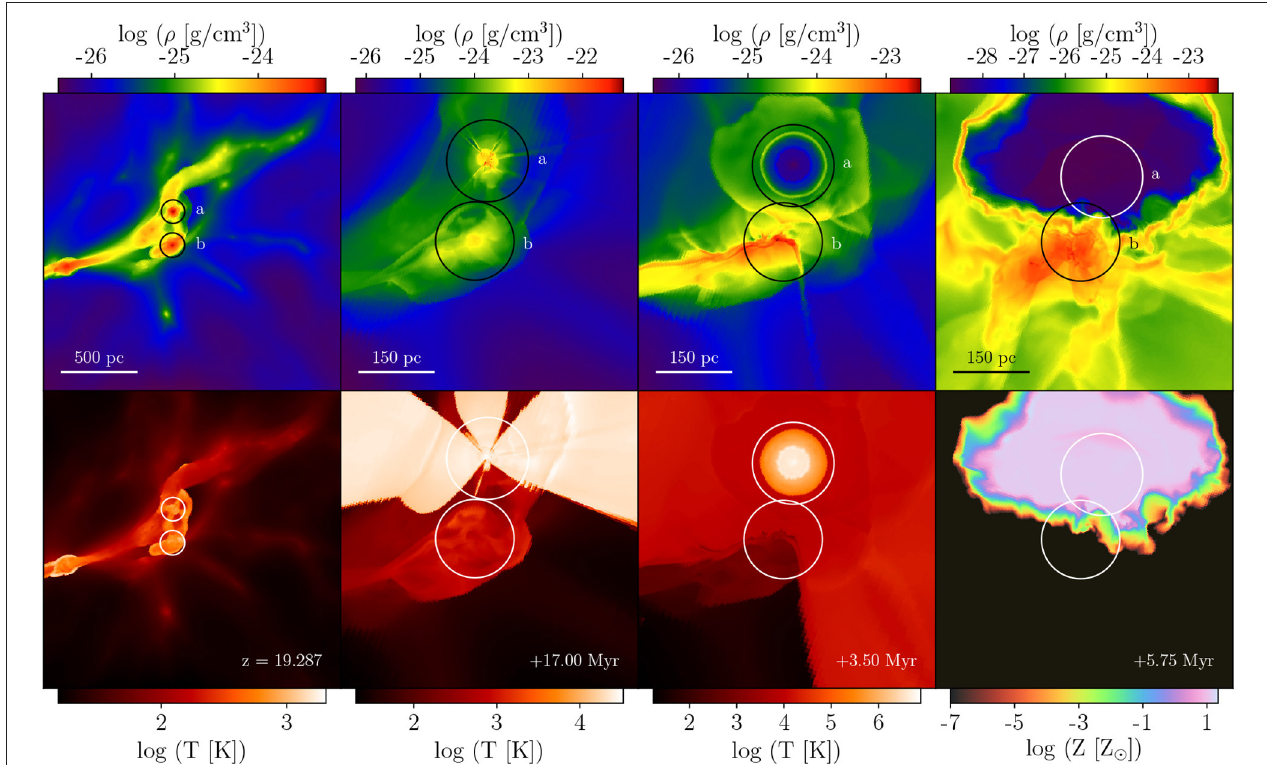
FIGURE 4 | The external enrichment of a starless minihalo (halo b) by a Pop III supernova from a nearby minihalo (halo a). The top row shows slices of the gas density and the bottom shows gas temperature and metallicity in the right-most panel. Circles denote the virial radii of the two halos. Column 1: the two halos are shown at z ∼ 19, shortly before the formation of a Pop III star in halo a. Column 2: the star forms in halo a and ionizing radiation immediately escapes. Column 3: the star explodes in a core-collapse supernova. Radiation from the star has compressed the gas in halo b and its encompassing filament. Column 4: the metal-rich blast-wave impacts halo b. Turbulent motion will enable the metals to mix into the densest gas within halo b. A reproduction of Figure 1 from Smith et al.